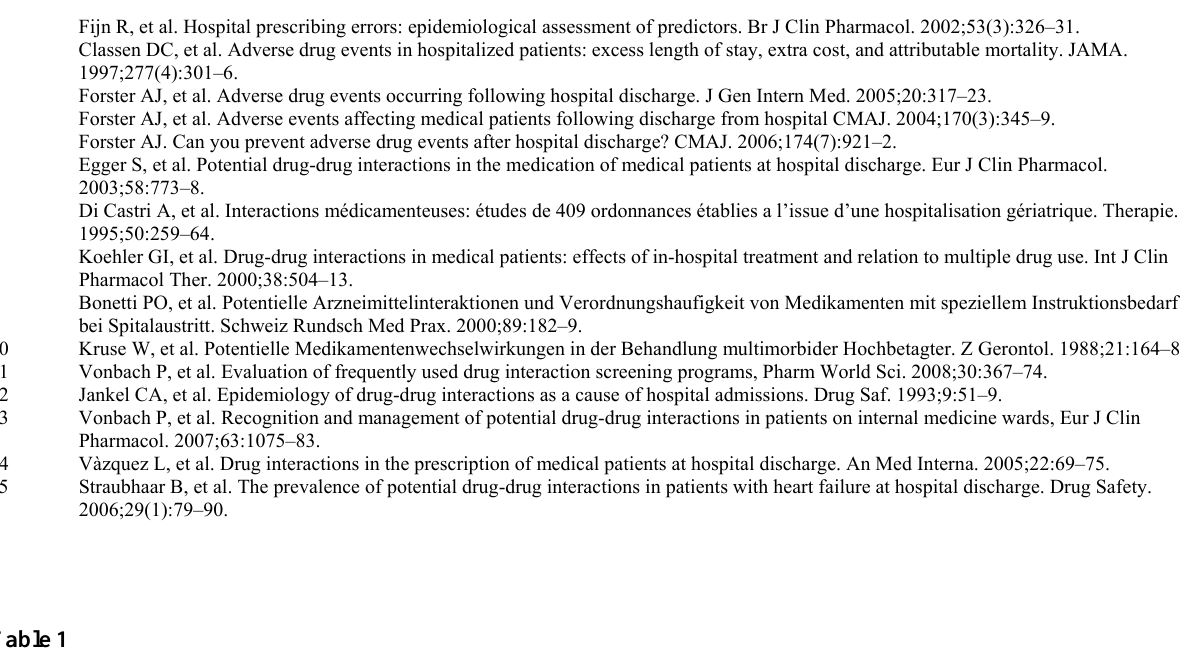
Detected DDI of major